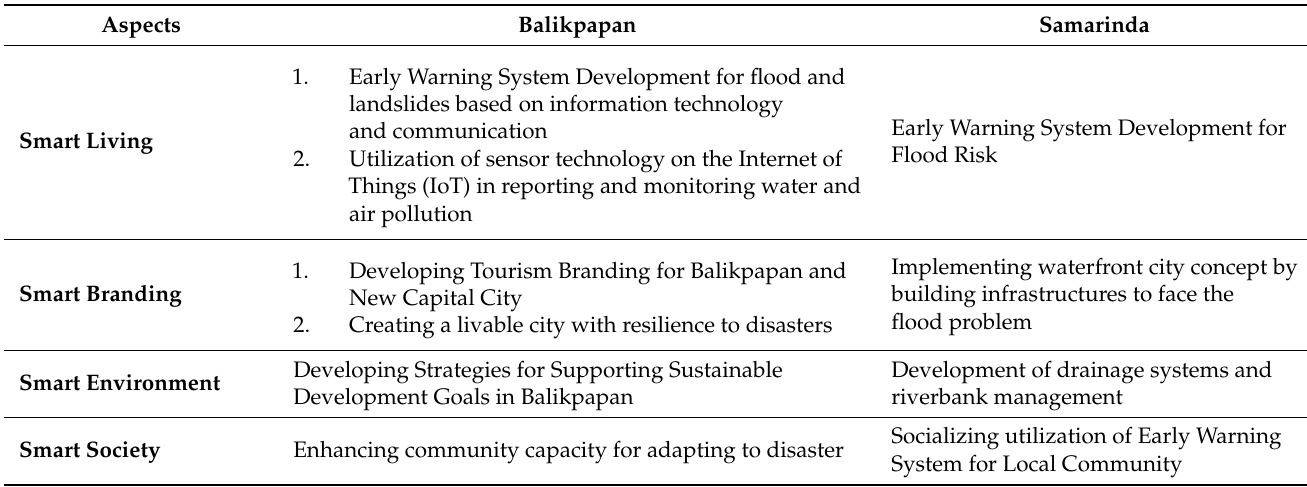
Table 3. Summary of smart city masterplan regarding disaster management in Balikpapan and